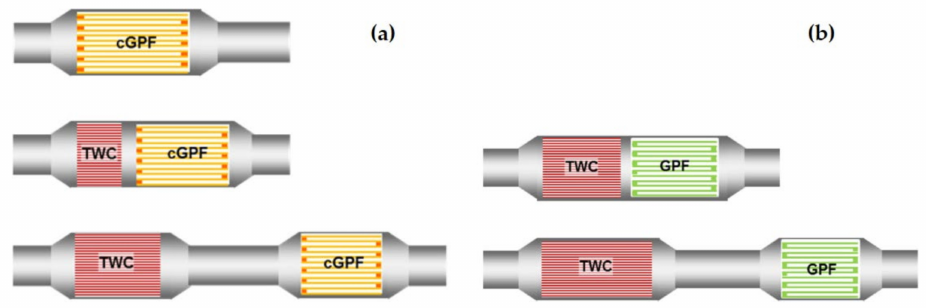
Figure 4. Gasoline system architecture with GPF: TWC-coated cGPF ( a ) and uncoated GPF systems ( b ). From reference